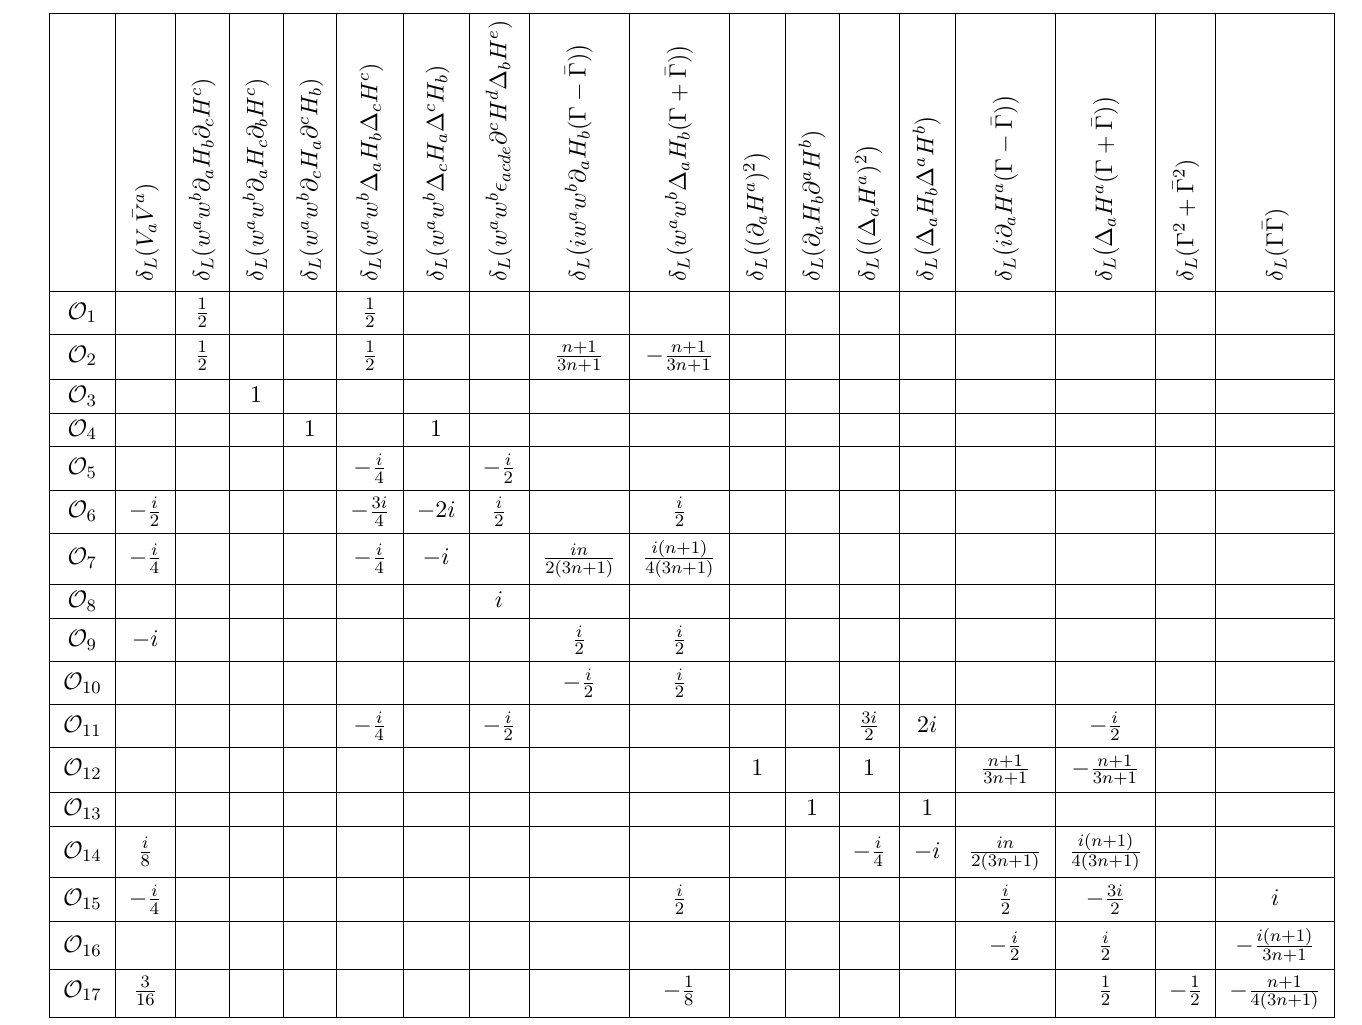
Table 1 . The coefficients in the gauge variations of CP -even operators. Only non-zero entries are